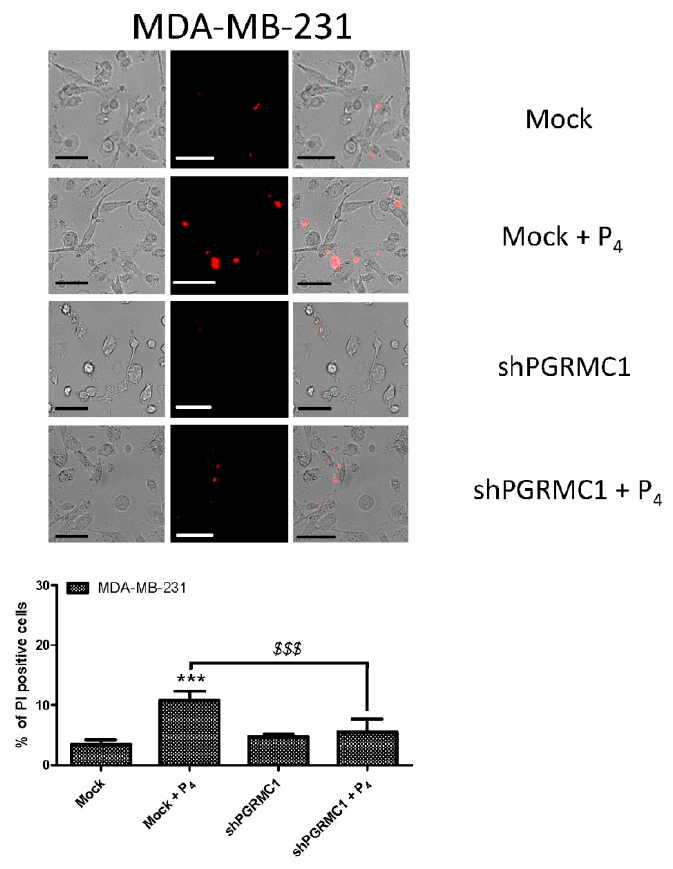
Figure 8. Protesterone (P 4 ) induced cell death of the MDA-MB-231 cells. MDA-MB-231 cells were transfected with the scrambled (Mock) or the small hairpin siRNA against the progesterone receptor membrane component 1 (shPGRMC1) plasmids for 48 h. After confirmation of the efficiency of the silencing protocol by Western blotting, cells were cultured for an additional 24 h in the absence or presence of P 4 (1 μ M). Following this, cells were incubated on the day of the experiment with 4 μ M of propidium iodide (PI) for 45 min at 37 °C inside the incubator. Cell images were acquired at 555/624 nm of wavelength (excitation/emission, respectively), by using a 40× objective mounted in a fluorescence microscope. The percentage of positive PI loaded cells with respect to the total counted cells in the fields was estimated, considering the mean ± Standard error of the mean (S.E.M.) of 3-4 independent experiments, and was represented in the bar chart. ***: represents p < 0.001 with respect to the mock resting cells; meanwhile, $$$ : represents p < 0.001 with respect to the cells expressing PGRMC1 and treated with P 4 . The bar in the images represents 50 μ m.